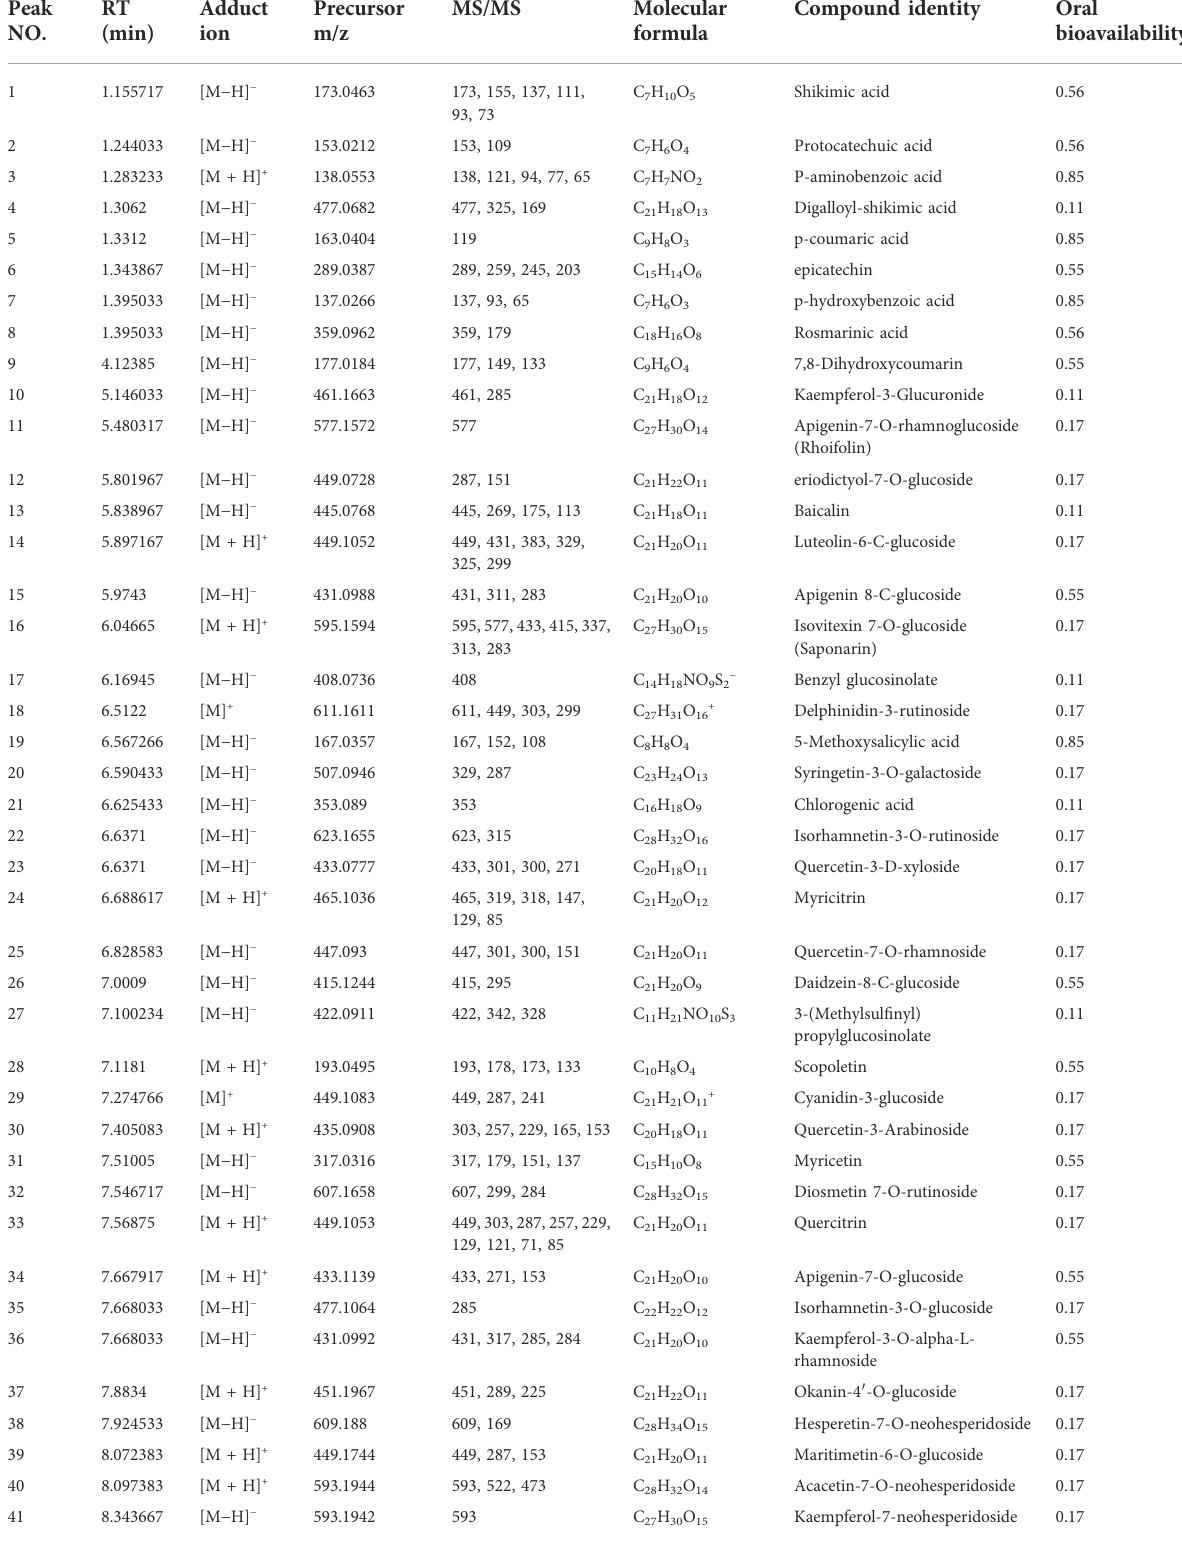
TABLE 4 Characterization of the chemical constituents in MA ethanolic extract using LC-ESI-MS/MS analysis. Peak